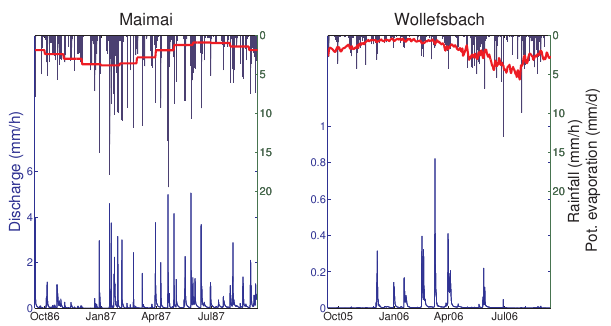
Fig. 5. Catchment area of the Maimai study area in New Zealand: the M8 catchment is one of the side branches of the main creek. Left: red dot indicates the location in New Zealand, right: topo- graphic map of the Maimai study area with indicated the catch- ment boundary of the M8 catchment (source: http://www.topomap.